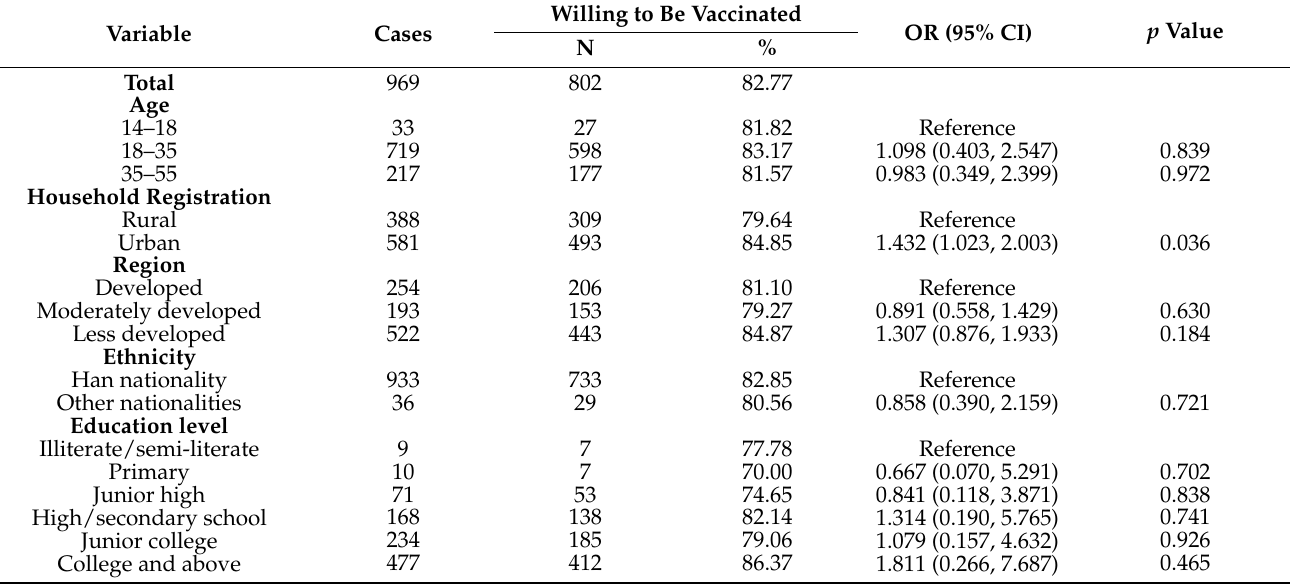
Table 1. Comparison of differences in HPV vaccination willingness among different demographic characteristics in